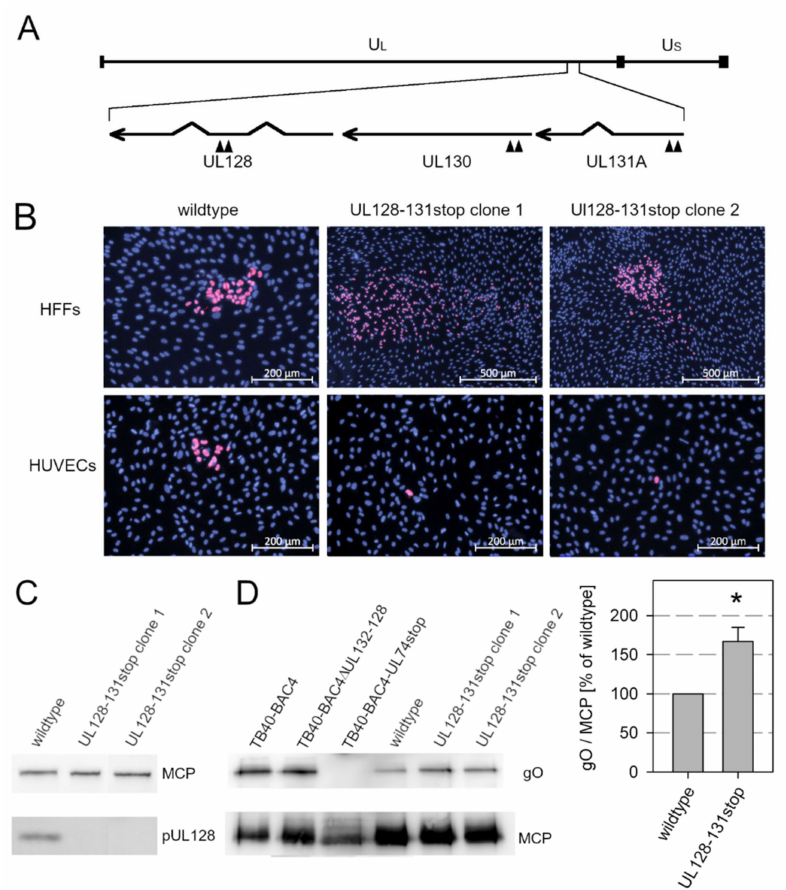
Figure 2. Effect of stop mutations in viral genes encoding for the accessory proteins of the pentamer complex. ( A ) Schematic representation of the viral genome with the unique long and the unique short section indicated by UL and US, respectively. The UL128 gene locus is shown enlarged below the genome map, and the positions of the stop codons that were introduced into the open reading frames of UL128, UL130, and UL131A are indicated by arrow heads. ( B ) Virus reconstituted in HFFFtet cells from wildtype Merlin pAL1502 or mutant genomes was used to infect fibroblasts (HFFs) which were then cocultured with an excess of uninfected HFFs or endothelial cells (HUVECs) for 5 d. After the incubation time, cultures were fixed and immunostained for viral immediate early (IE) antigen. ( C ) Lysates of infected HFFs were analyzed by separation on a 10% polyacrylamide gel under reducing conditions and subsequent immunoblotting with antibodies against pUL128 to test whether the knockout of UL128 was successful. The major capsid protein (MCP) was detected as a loading control. ( D ) Virus particles were prepared from infected HFFs (TB40-BAC4 and derivatives) or HFFFtet cells (Merlin pAL1502 wildtype and UL128-131stop mutants) by gradient purification and lysed. Lysates were separated on a 10% polyacrylamide gel under nonreducing conditions and analyzed by immunoblotting with antibodies against glycoprotein O (gO) or MCP (loading control). For Merlin wildtype and mutants, the ratio of gO/MCP signals were determined to evaluate the effect of the knockout of the UL128 locus genes on the incorporation of gO into virion particles. Bars indicate mean values of four replicates with wildtype (two blots of two independent preparations) and eight replicates of UL128-131stop (two blots of two independent preparations of each of the two clones). Error bars represent the standard error of the mean (SEM). The asterisk indicates a significant difference as compared with wildtype (*, p <